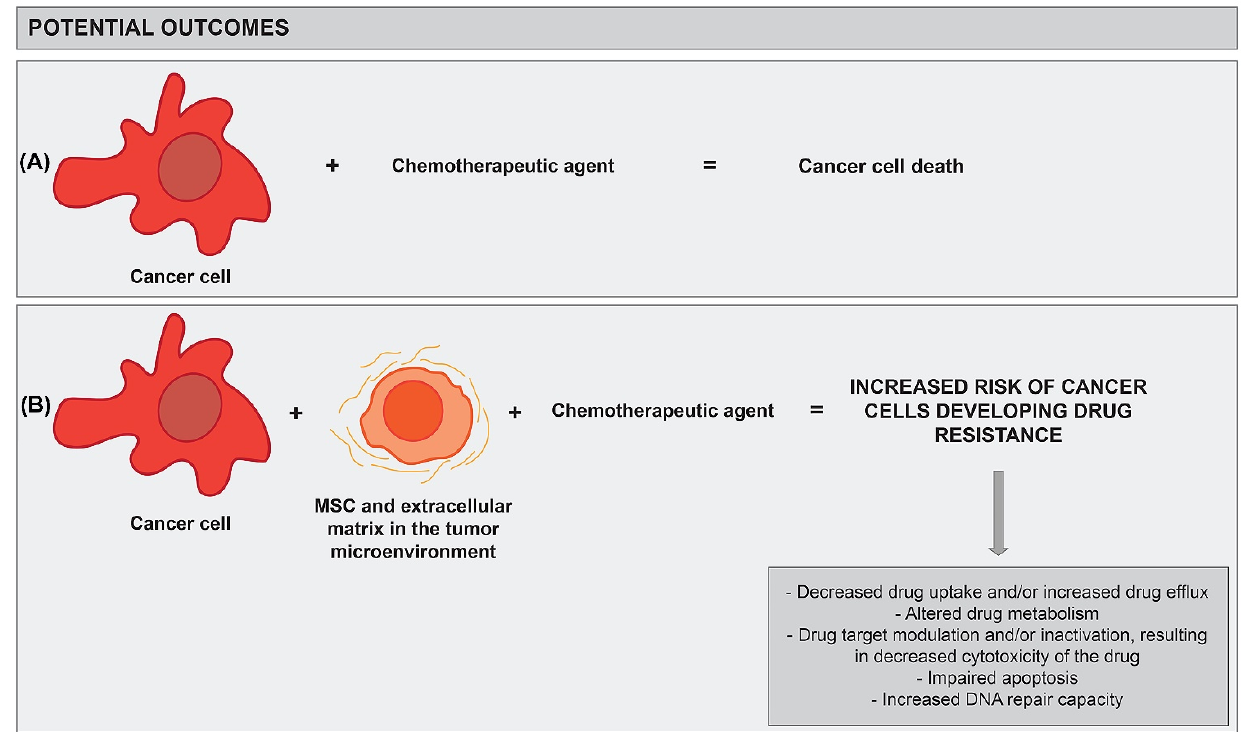
Figure 1. MSCs in the tumour microenvironment affect the success of anticancer therapy. There are two potential outcomes: ( A ) chemotherapeutic agents induce cell death in cancer cells or ( B ) the interaction of cancer cells, treated with a chemotherapeutic agent, with MSCs and the extracellular matrix in the tumour microenvironment may result in an increased risk of cancer cells developing drug resistance.